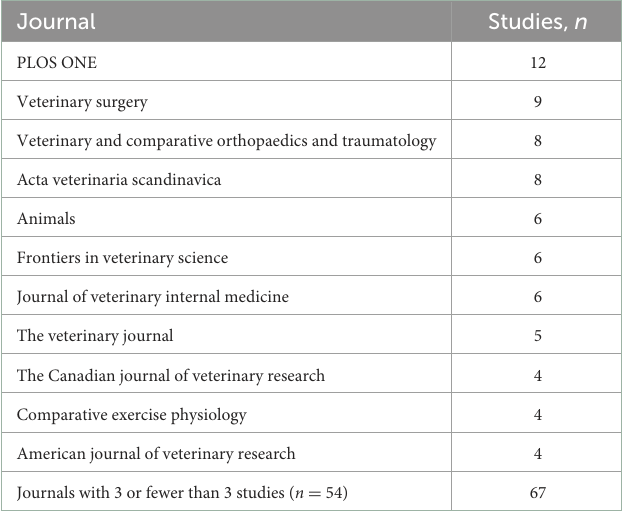
TABLE 4 The most represented journals of the included